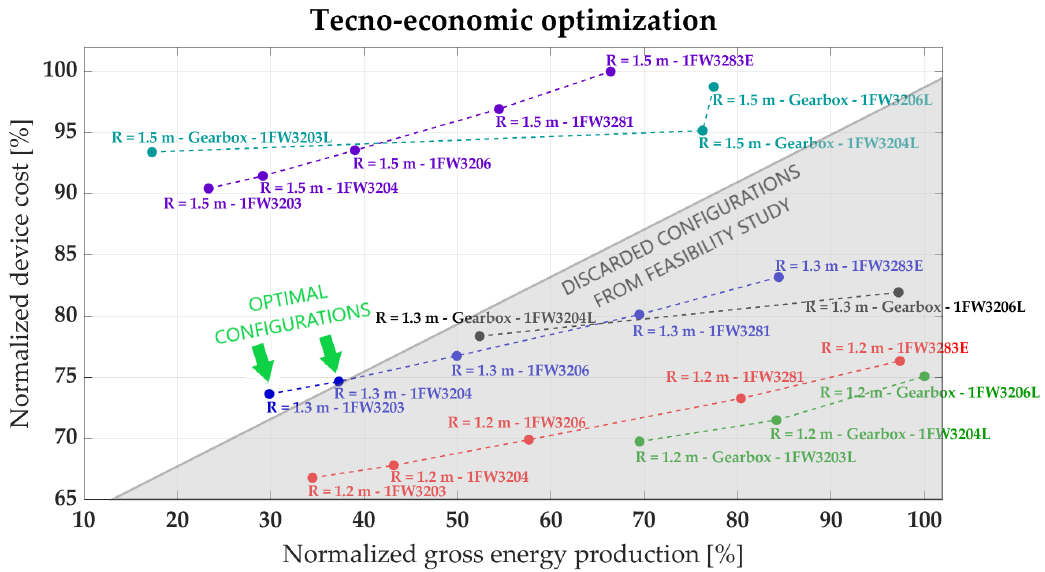
Figure 15. Normalized device cost and gross energy production of different configurations analyzed (the grey area is considered